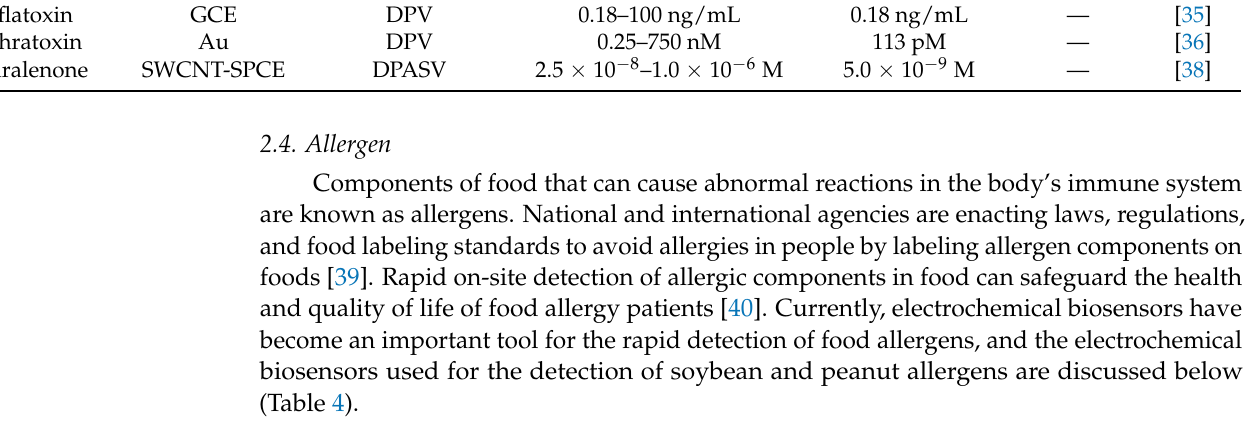
Table 4. Electrochemical biosensors for soy allergen